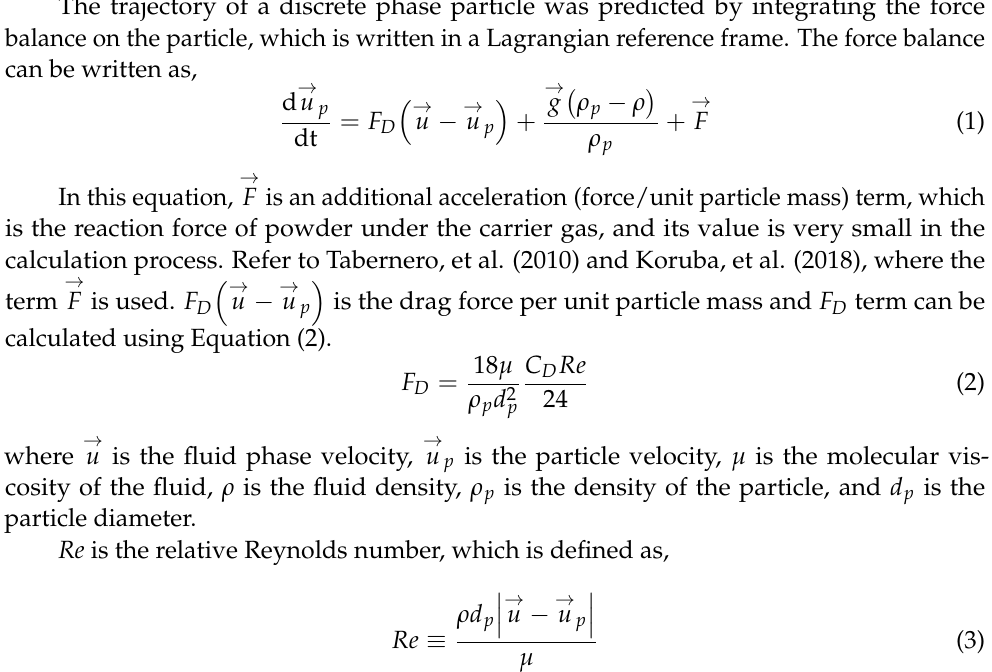
Figure 2. The definition of powder spot diameter. With a CCD camera, the powder stream convergence characteristics under given nozzle and gas settings were monitored. Figure 3 presents the trajectory of Ti6Al4V pow- der streams during the flying procedure out of the nozzle tip produced by CFD modeling and CCD photography (50 frames per second) respectively. By utilizing the same defini- tion method, the diameter of the photographed powder spot under different parameters were measured and compared with the simulation results. It was found that the calculated trajectories are in good agreement with the experimental observations, and they provide a good insight into the process phenomena.